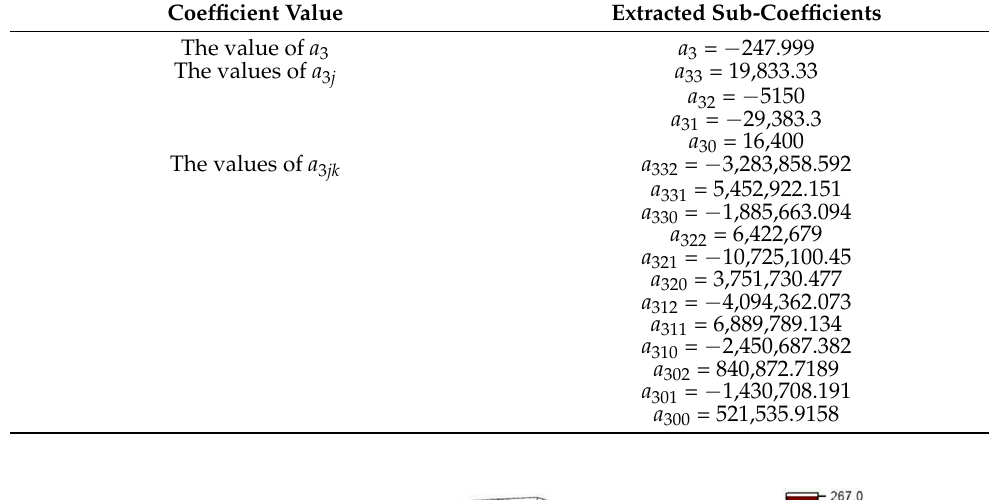
Table 3. The values of the coefficients in section X = a under V GS = 0.8 V and L mask = 500 nm.